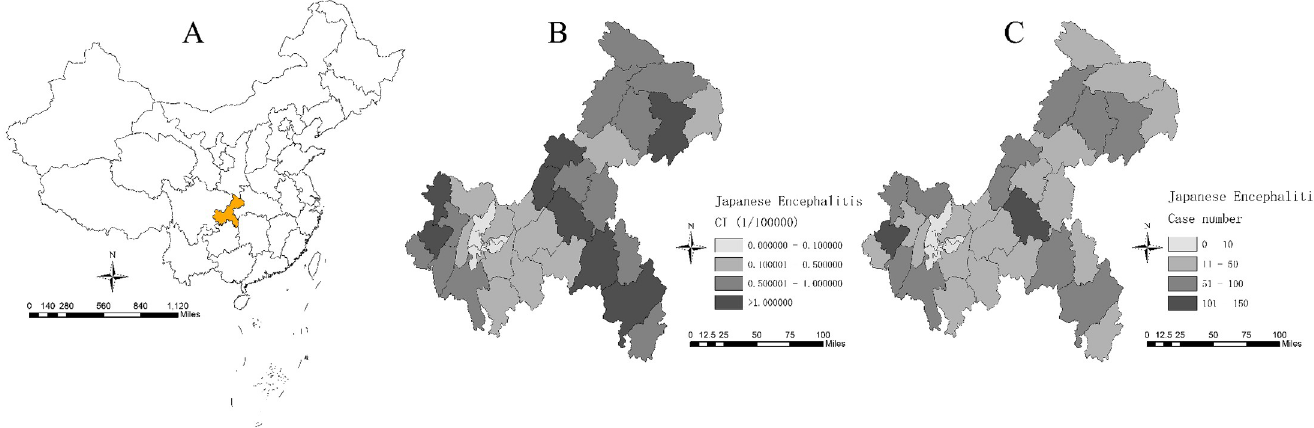
Fig 1. Spatial distribution of the study area and Japanese encephalitis (JE) cases. (A) The location is in Chongqing, China. (B) Spatial distribution of JE cases at the county level from 2007 to 2019 in Chongqing. (C) Cumulative incidence (CI) of JE cases at the county level from 2007 to 2019 in Chongqing.